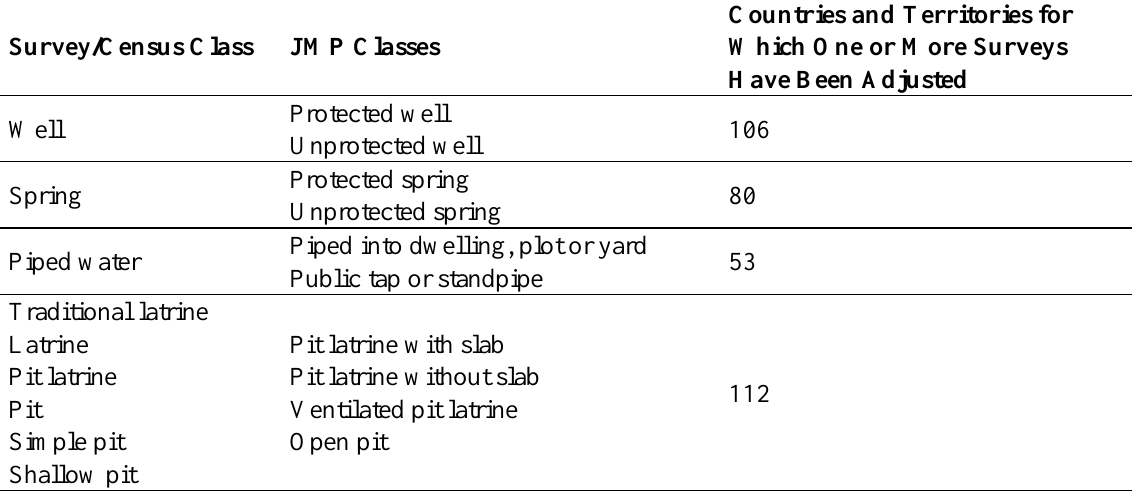
Table 3. Frequency of correction of surveys to account for differences between census/survey and JMP classes of water and sanitation since the start of JMP